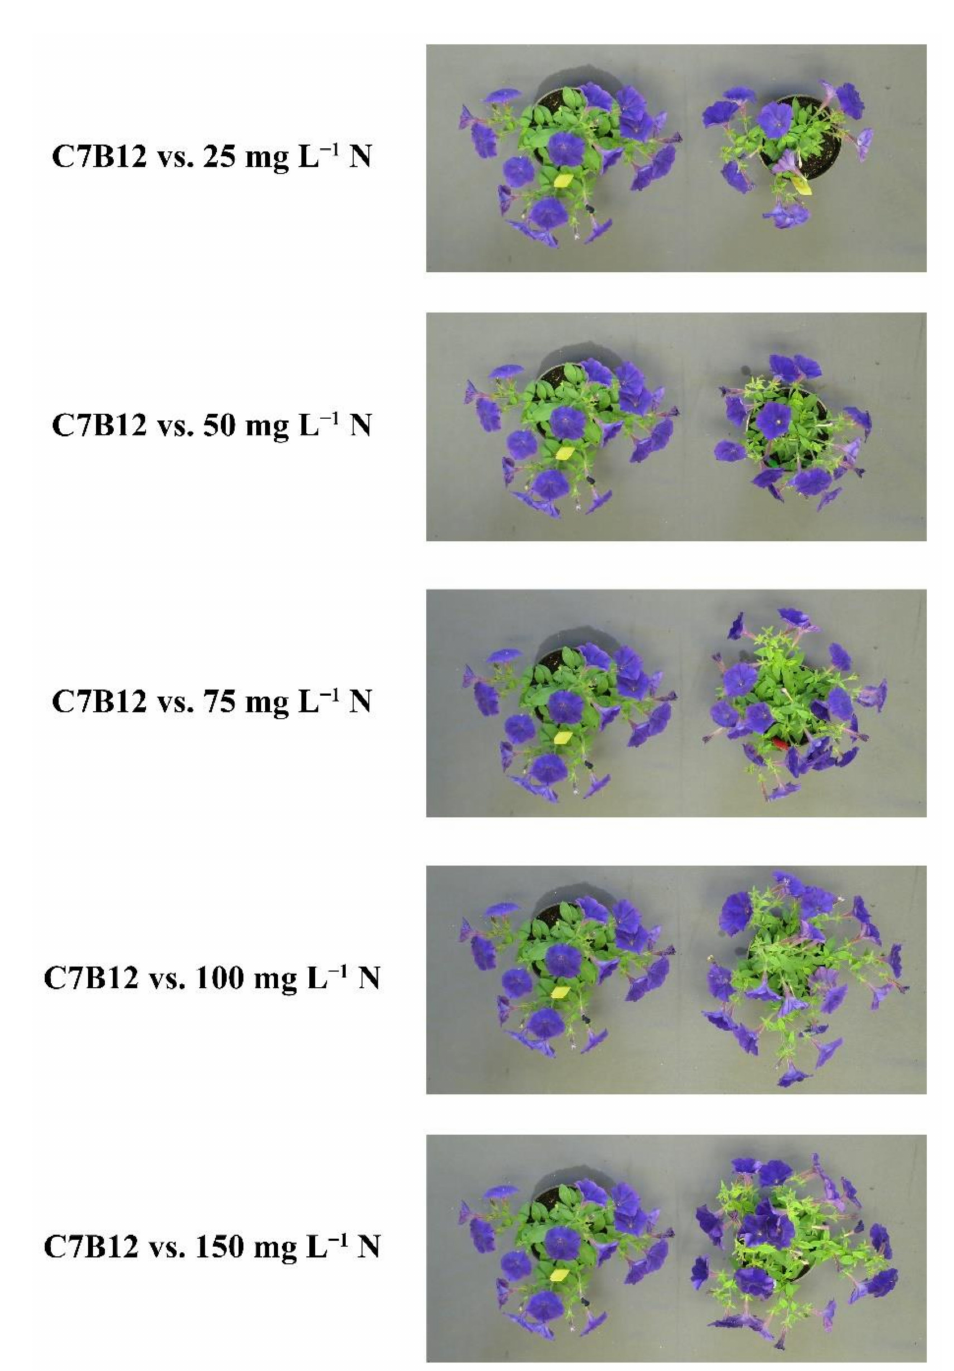
Figure 10. Visual quality of Petunia × hybrida ‘Picobella Blue’ treated with bacterial strain C7B12 and the fertilizer controls (no bacterial treatment). Plants treated with C7B12 were fertilized with 25 mg L − 1 N at each irrigation. The negative control plants were fertilized with 25 mg L − 1 N, and the four positive fertilizer controls were fertilized with 50, 75, 100, or 150 mg L − 1 N (no bacterial